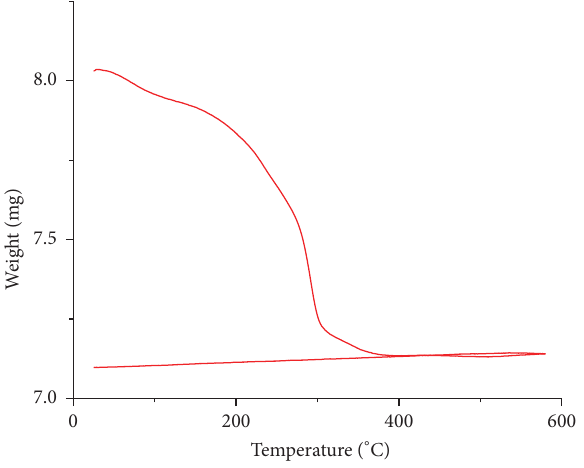
Figure 2: TGA analysis of as-synthesized